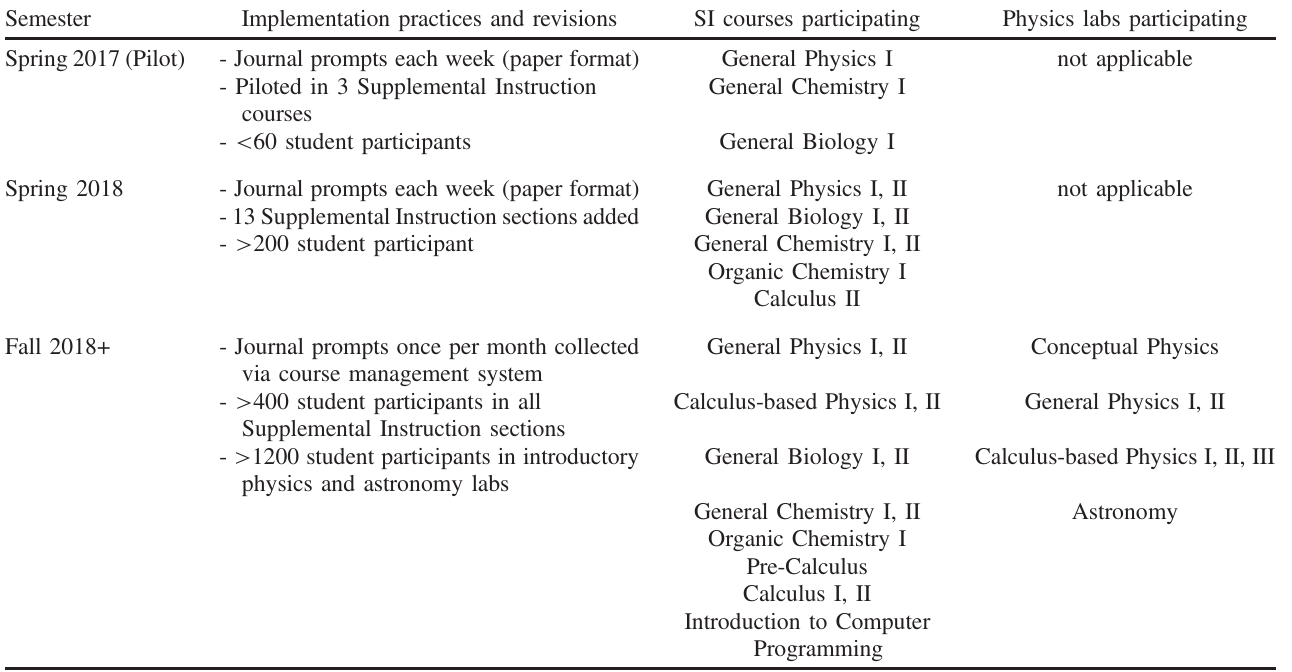
TABLE IV. Growth of the Alma Project.